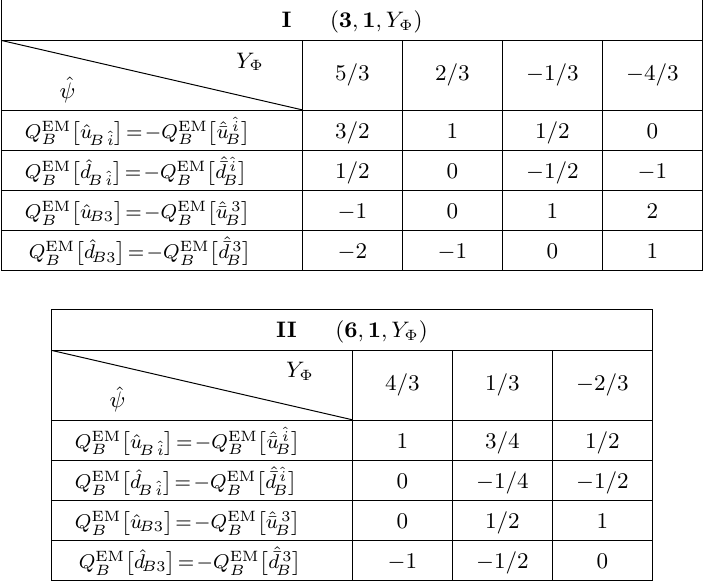
Table 1 . Twin quark electric charges in cases I triplet (left) and II sextet (right) for several choices of scalar hypercharge Y (cid:8)